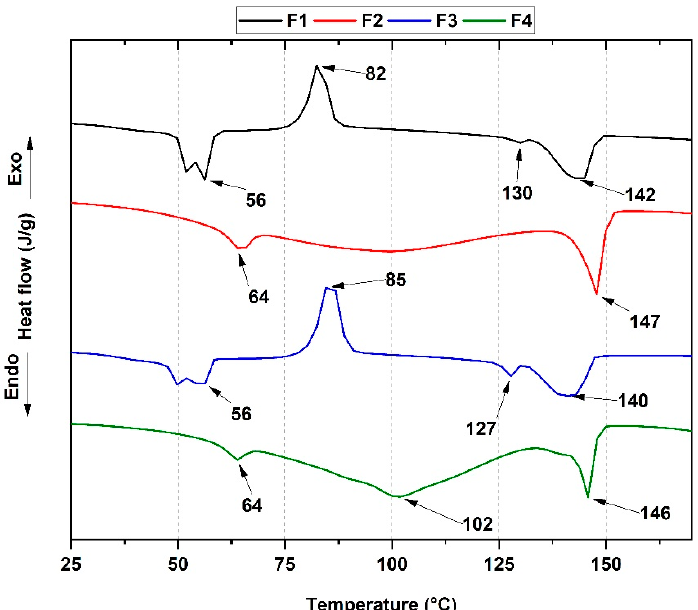
Figure 7. DSC curves of the PCL/PLA/ZnO-NPs/Gly/TTEO nanocomposites. Formulations: F1, 25%PCL/70%PLA/5%Gly; F2, 22%PCL/70%PLA/5%Gly/3%ZnO-NPs; F3, 15%PCL/70%PLA/5%Gly/10%TTEO; F4, 17%PCL/70%PLA/5%Gly/3%ZnO-NPs/10%TTEO.